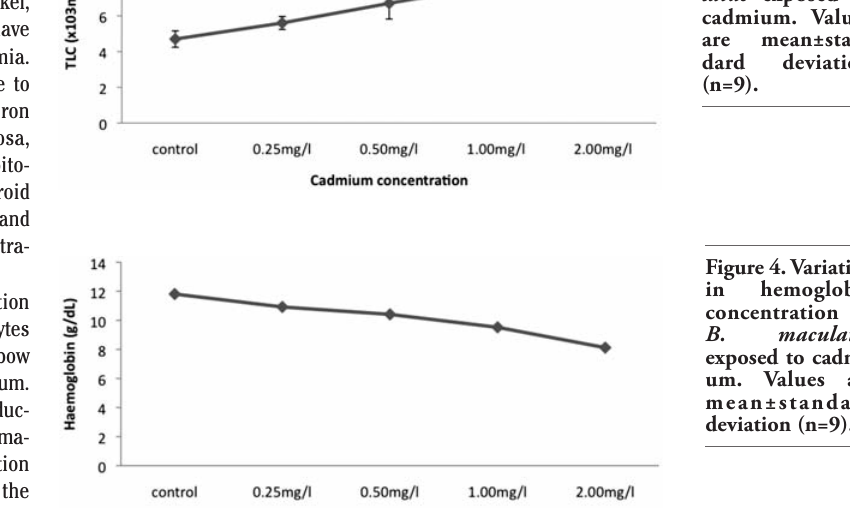
Figure 3. Variation in total leukocyte count in B. macu- latus exposed to cadmium. Values are mean±stan- dard deviation (n=9).